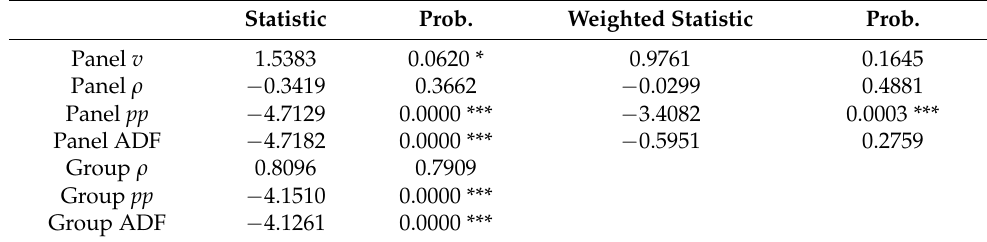
Table 5. Heterogeneous panel cointegration